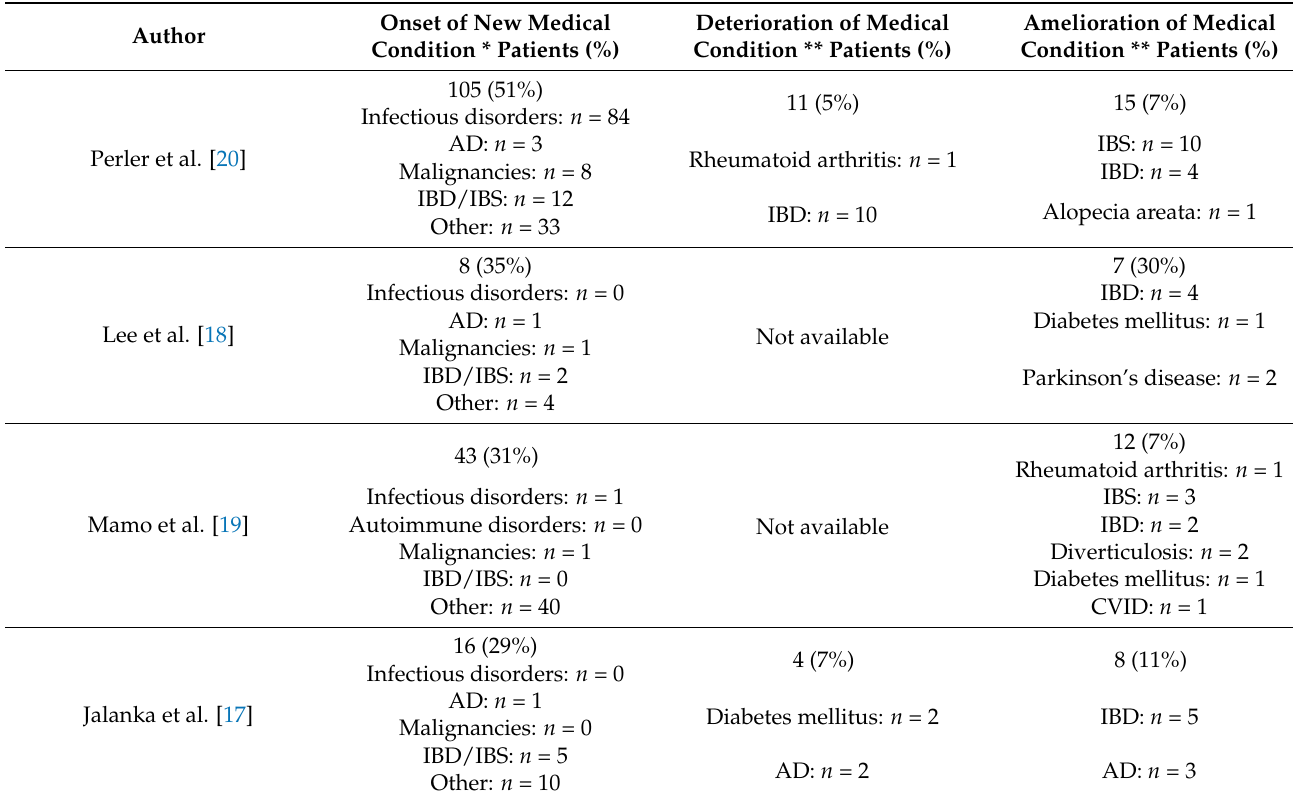
Table 4. Studies reporting on other medical conditions